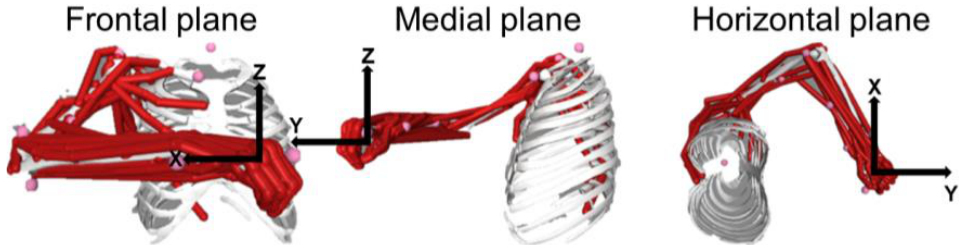
Figure 7. Musculoskeletal model posture on a frontal ( left panel ), medial ( middle panel ), and horizontal ( right panel ) planes. The model was set to assume the same posture that participants assumed during the isometric task.